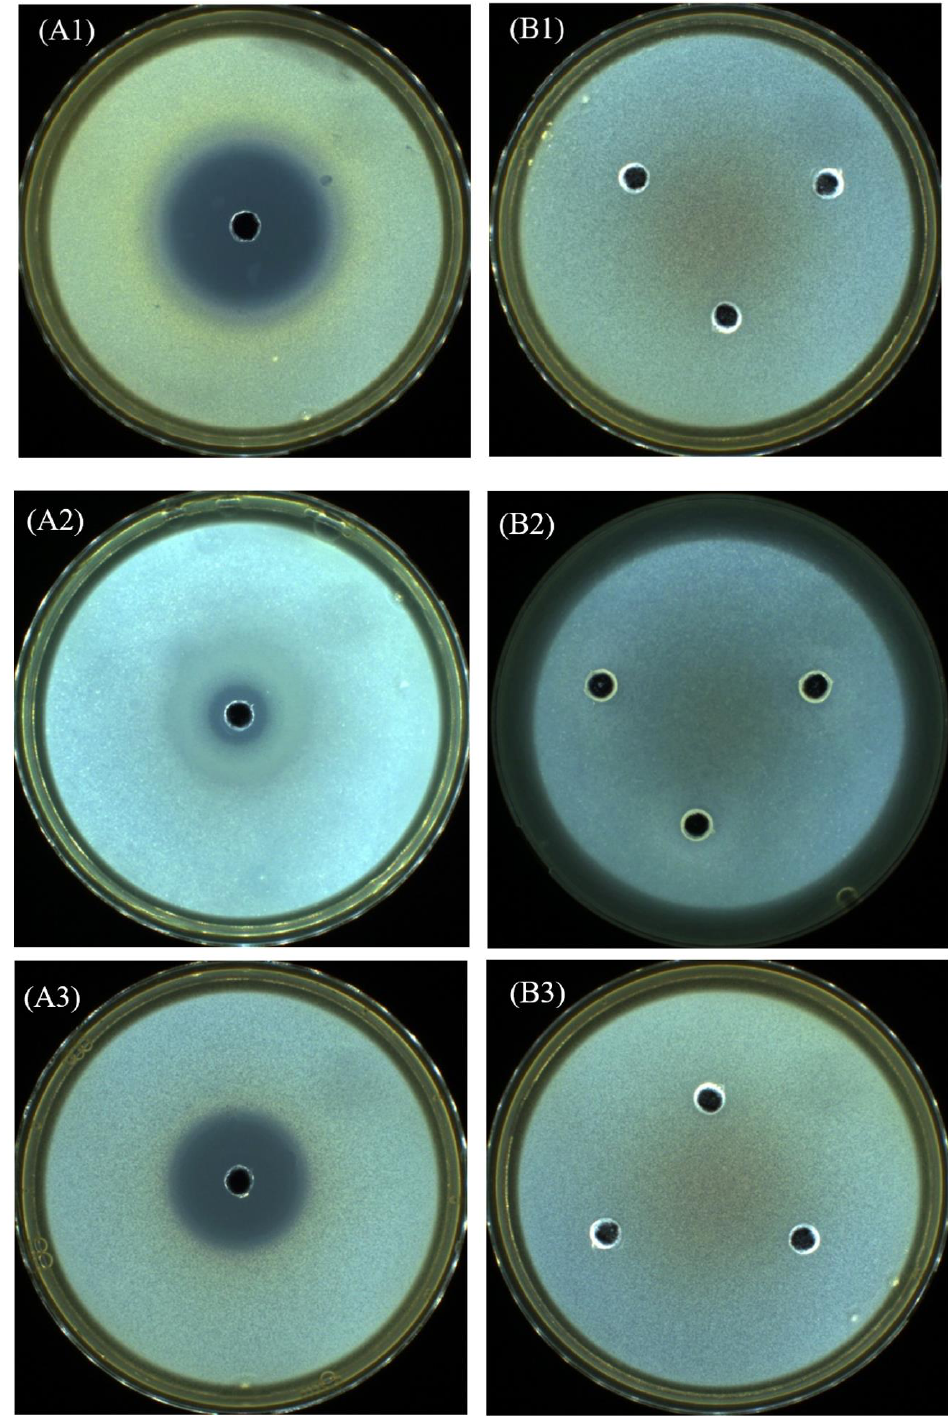
Figure 13. Antimicrobial susceptibility test using disk diffusion method for sample ( A ) E-CMC-CEL hydrogel and ( B ) TC loaded E-CMC-CEL hydrogel at initial 40 µ g mL − 1 tetracycline concentration in PBS buffer pH 7.4 at 25 °C for 2 h toward microbials: ( 1 ) Staphylococcus aureus ATCC 29213, ( 2 ) Pseudomonas aeruginosa ATCC 27853 and ( 3 ) Escherichia coli ATCC 25922. Table 1. Antimicrobial activity test of tetracycline loaded E-CMC-CEL and swelled E-CMC-CEL hydrogels.